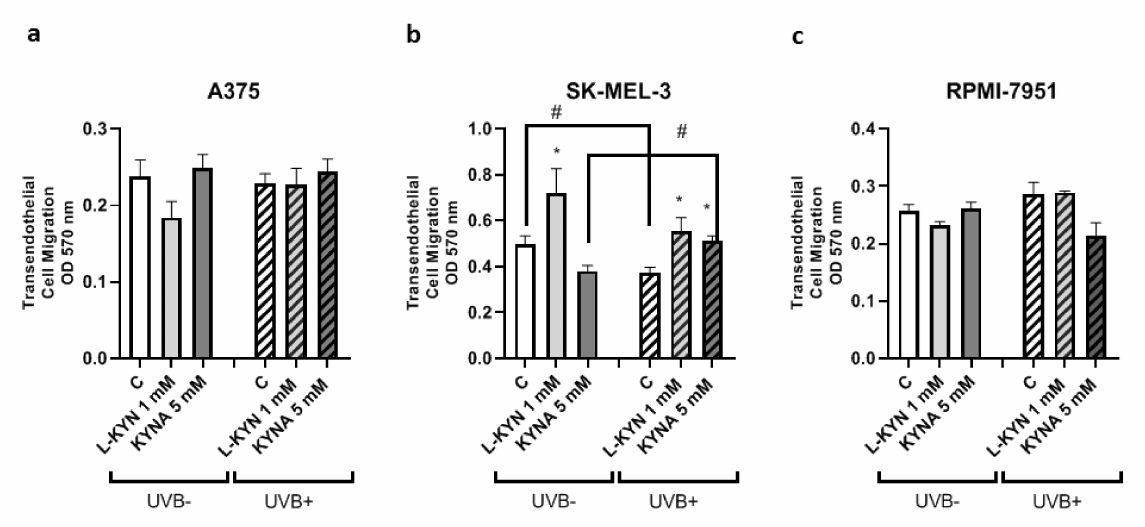
Figure 2. The effect of UVB on the invasiveness and motility of melanoma A375 ( a ), SK-MEL-3 ( b ) and RPMI-7951 ( c ) cells exposed to KYN and KYNA. Melanoma A375, SK-MEL-3, and RPMI-7951 cells were exposed to UVB and then to